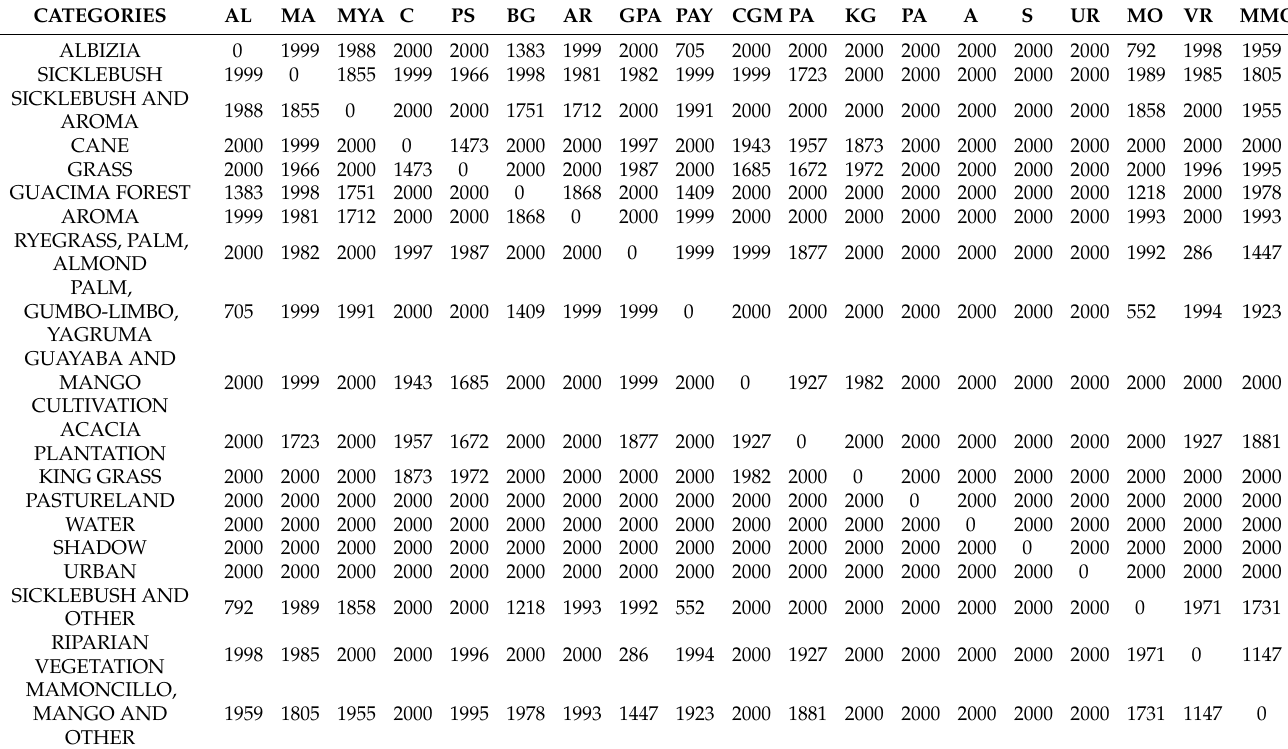
Table 3. Separability matrix using the transformed divergence method for a WorldView-2 image of Trinidad-Valle de los Ingenios,